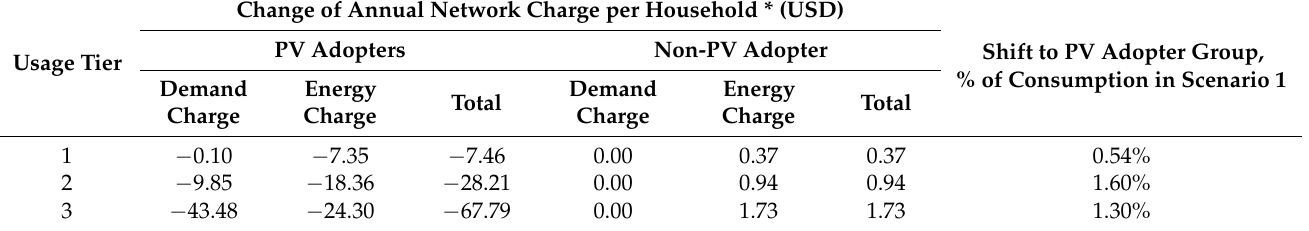
Table 6. Changes of annual network charge and net consumption between scenarios 1 and